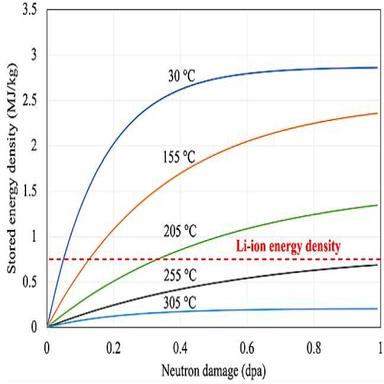
Evolution of the stored energy density in graphite as function of neutron damage at different temperatures (data (). Source